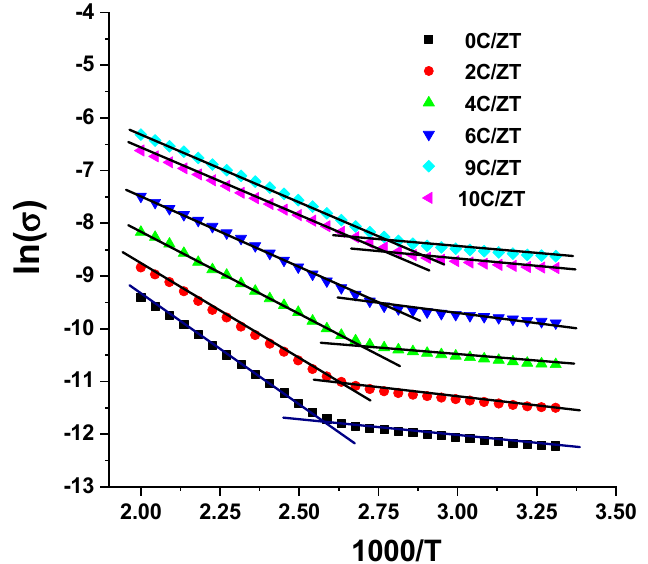
Figure 14. ln( σ ) versus 1000/T of undoped and Cu-doped ZnTe films with various Cu incorporation levels.